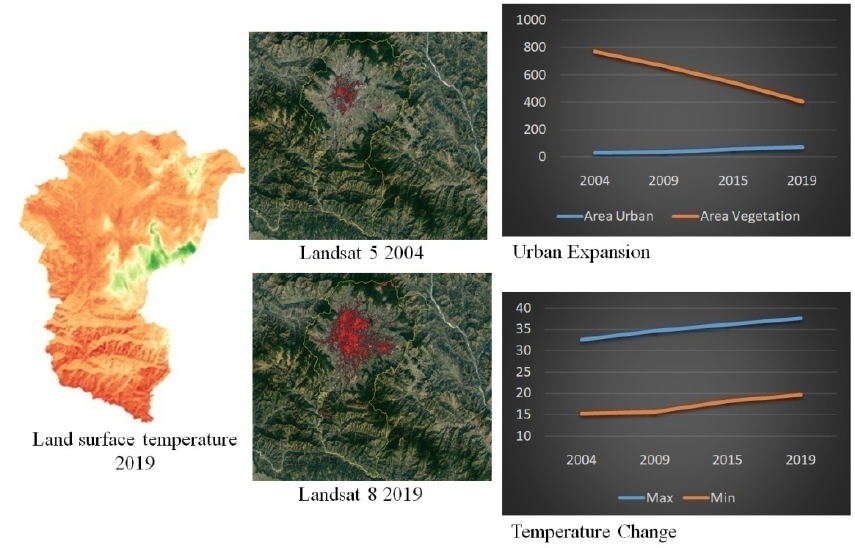
Figure 4. Relationship between Urban Growth and Land Surface Temperature for Kathmandu, Nepal Some of the major recommendations, taking into account of the participant feedback and future plans for the benefit BIMSTEC countries are highlighted below: